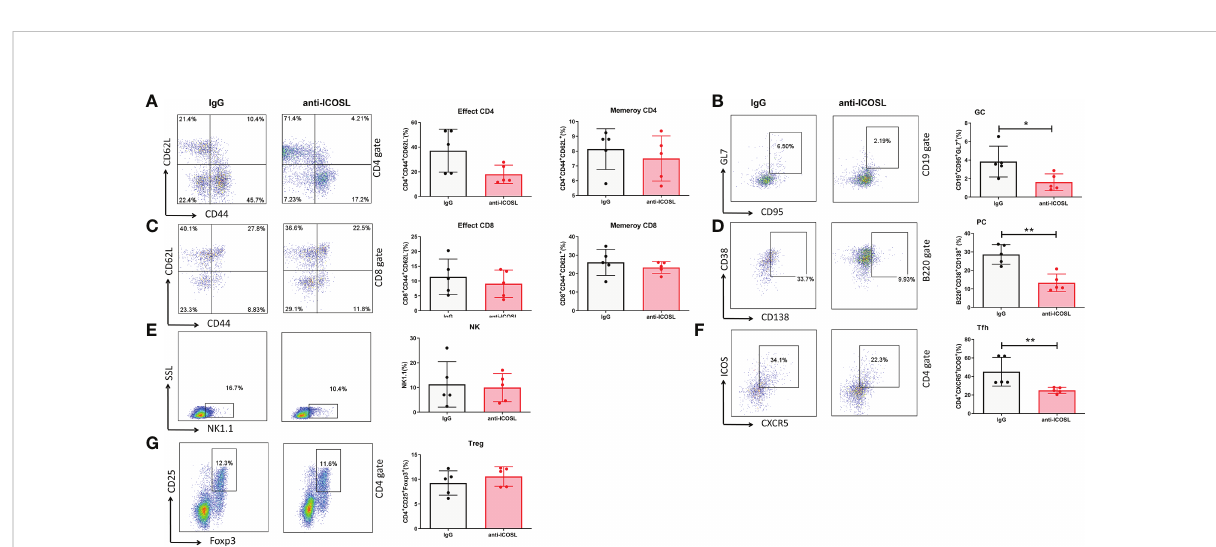
FIGURE 9 Different immunocytes in CIA mice treated with anti-ICOSL mAb (n = 5) or IgG (n = 5). (A) The percentages of effector CD4 and memory CD4 T cells. (B) The percentage of GC B cells. (C) The percentages of effector CD8 and memory CD8 T cells. (D) The percentage of PCs. (E) The percentage of NK cells. (F) The percentage of Tfh cells. (G) The percentage of Tregs. Bars show mean ± SD; * P < 0.05, ** P <